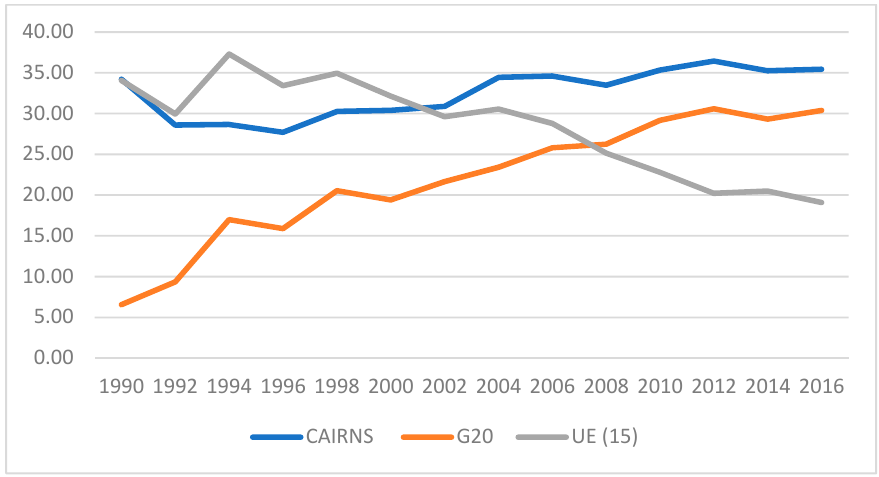
Figure 4. Share of EU (15), CAIRNS and G20 in world exports of continental products. Source: own elaboration from data obtained from UN Comtrade Database.